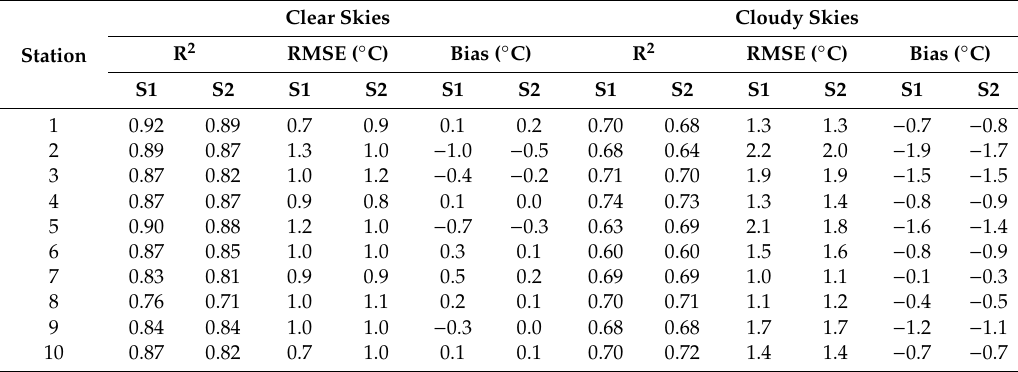
Table 4. The leave one-station out cross-validation (LOOCV) results of the estimated 1 km clear and cloudy sky LSTs from scheme 1(S1) and scheme 2(S2) using 1 km bias-corrected in situ LSTs for 10 stations during July and August from 2013 to 2018 for nighttime. Refer to Figure 1 for station